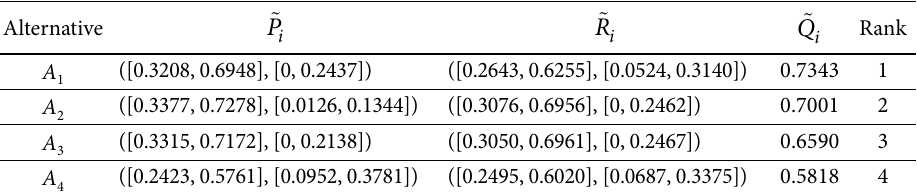
Table 6. The values of i P  , i R 